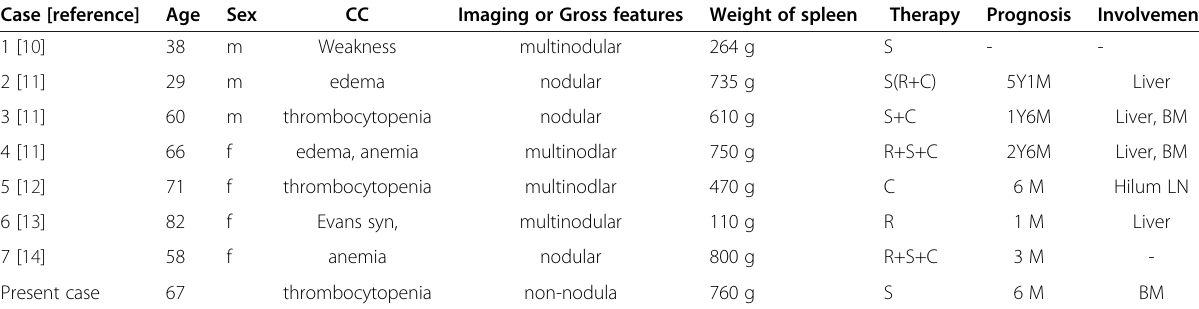
Table 1 Comparison of the main clinical features among the reported cases with primary splenic HS, including